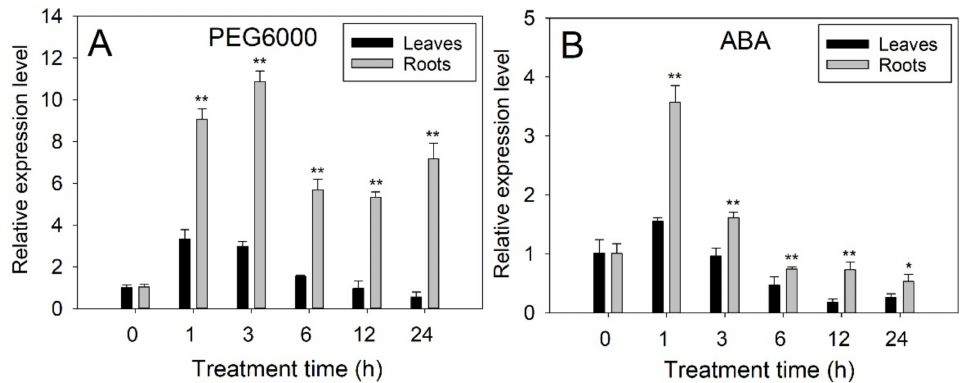
Figure 3. The expression analysis of PtrbHLH66 in leaves and roots of trifoliate orange after ( A ) drought (20% PEG6000) and ( B ) ABA (100 µ M) treatments. The y-axis records the relative gene expression levels as calculated by the 2 − ∆∆ CT method with trifoliate orange ACTIN gene as the endogenous reference. Data are shown as the means ± SD calculated from three biological replicates. Significant expression differences between the leaves and roots at the p < 0.05 and p < 0.01 levels are indicated by single (*) and double asterisks (**), respectively, according to Student’s t